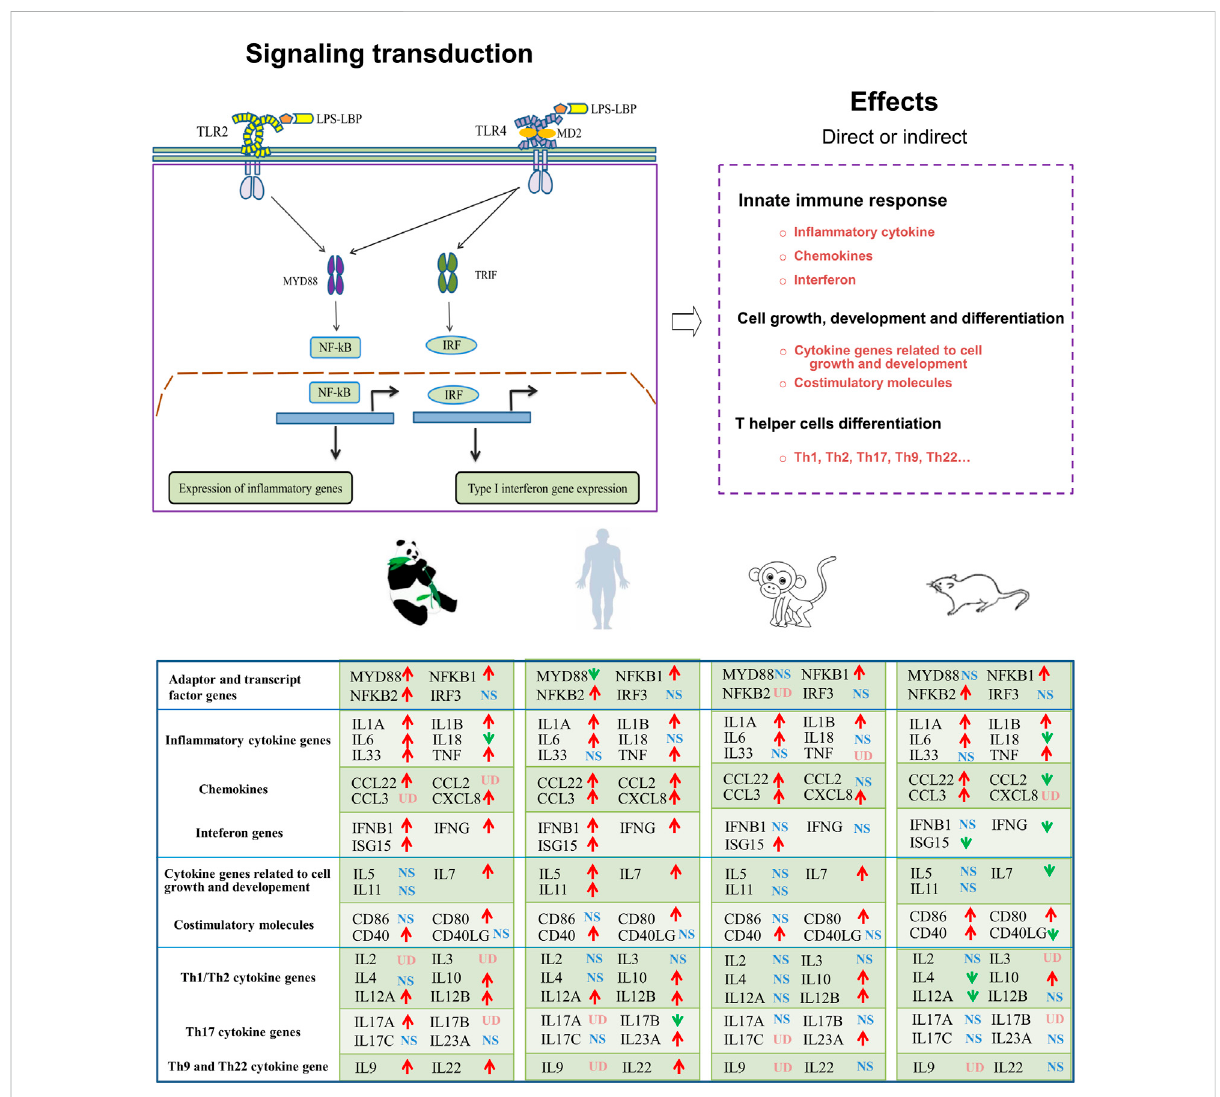
FIGURE 8 Graphic overview of the main signaling pathways and conclusions for the present study. LBP (LPS-binding protein); MD2 (myeloid differentiation factor 2); MyD88 (myeloid differentiation primary response 88); TRIF (TIR-domain-containing adapter-inducing interferon- β ); IRF (IFN-regulatory factor); UD (undetected); NS (non-signi fi cant differential expression); ↑ (signi fi cantly upregulated); ↓ (signi fi cantly